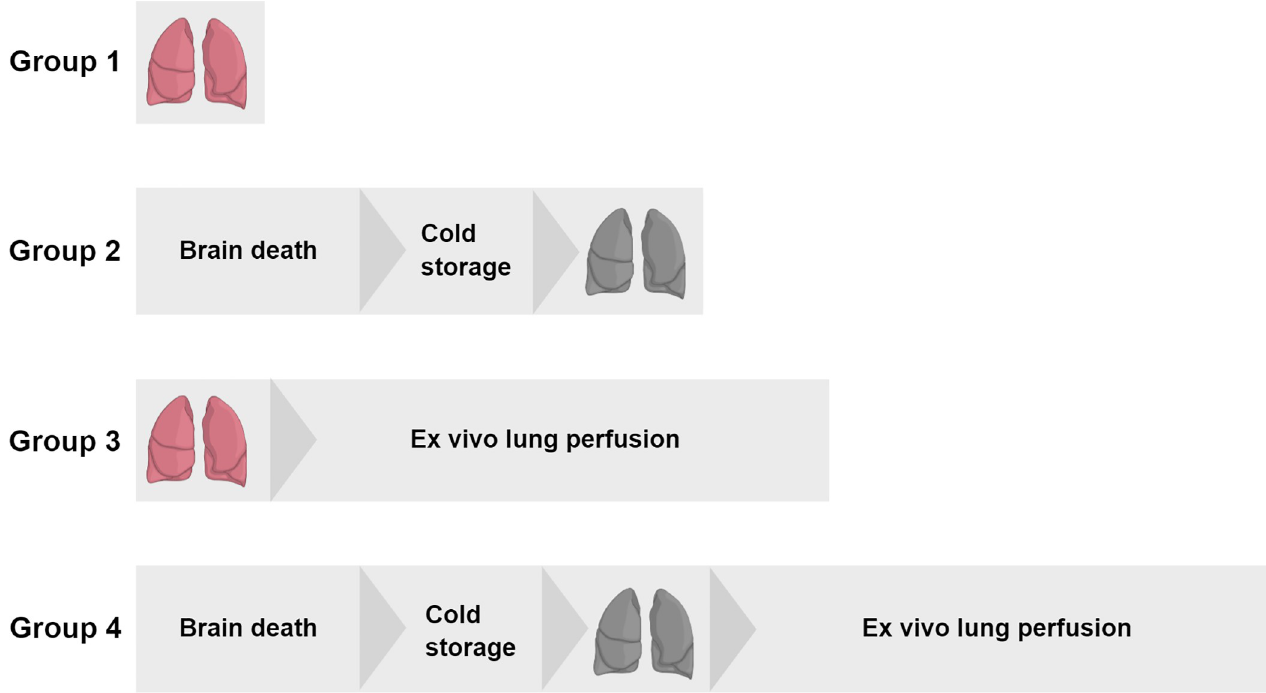
Fig 1. Experimental outline of the study. Lungs from donor rats were randomly assigned to one of four experimental groups (n = 7/group): 1) healthy, directly procured lungs, 2) lungs procured from rats subjected to 3 hours of brain death (BD) and 1 hour cold storage (CS), 3) healthy, directly procured lungs subjected to 6 hours ex vivo lung perfusion (EVLP) and 4), lungs procured from rats subjected to 3 hours of BD, 1 hour CS and 6 hours